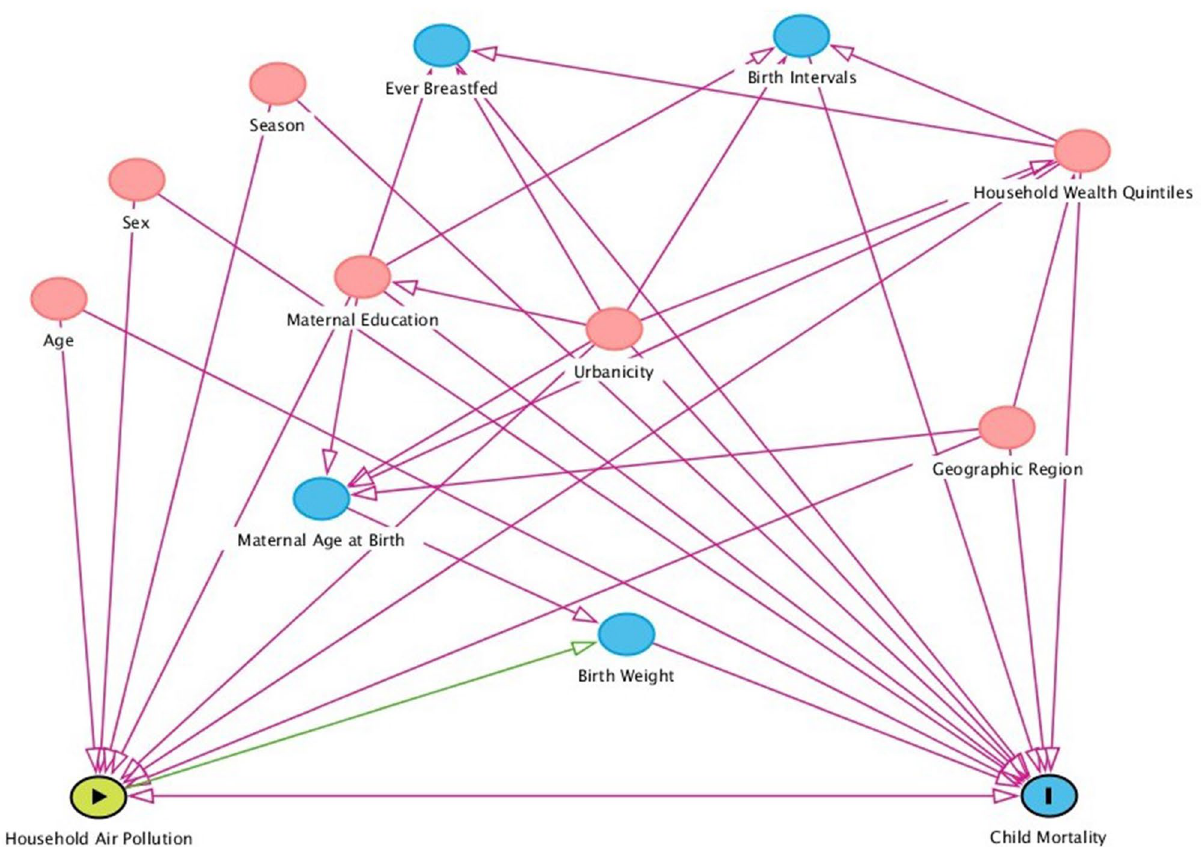
Figure 2. A directed acyclic graph (DAG) for evaluation of covariates selection in the analysis of effects of HAP on child mortality. HAP is exposure, and child mortality is the outcome. The minimal and sufficient adjustment set contains child age, child sex, breastfeeding status, maternal education, household wealth quintiles, urbanicity, geographic region, preceding birth interval, and season. This figure was constructed through DAGitty (http:// www. dagit ty.